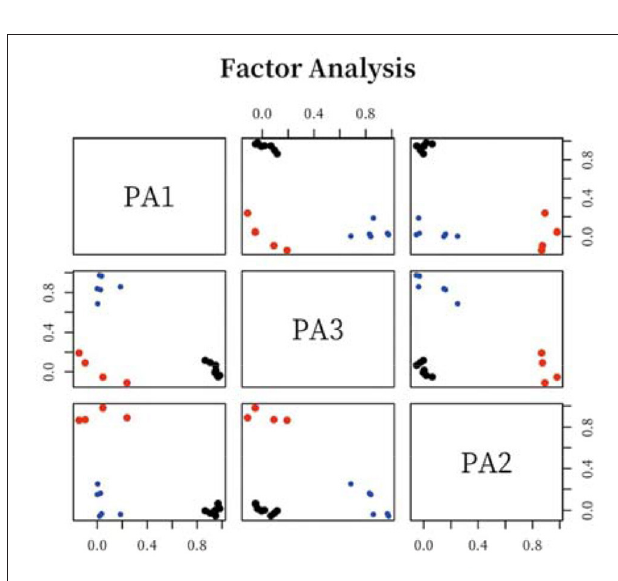
FIGURE 8 | Distribution of color semantics in the two-dimensional cognitive